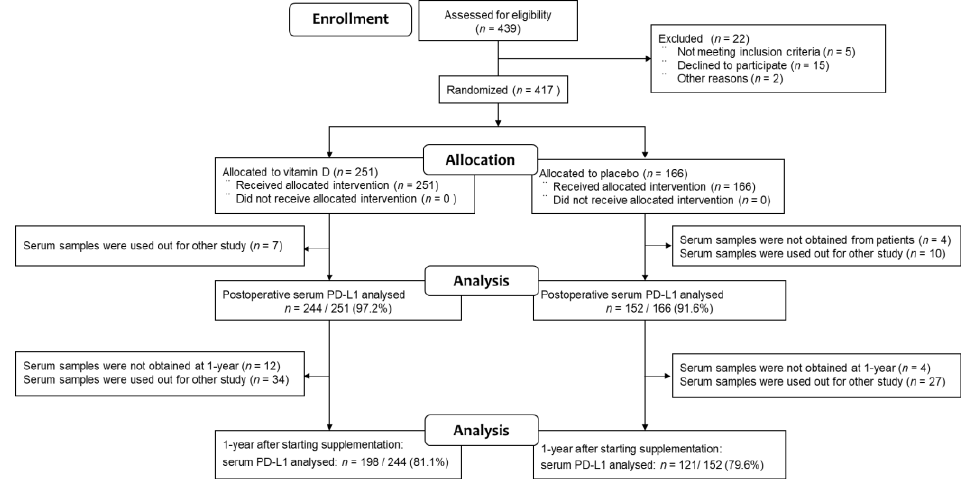
Figure 1. Patient flowchart through the present post hoc analysis.